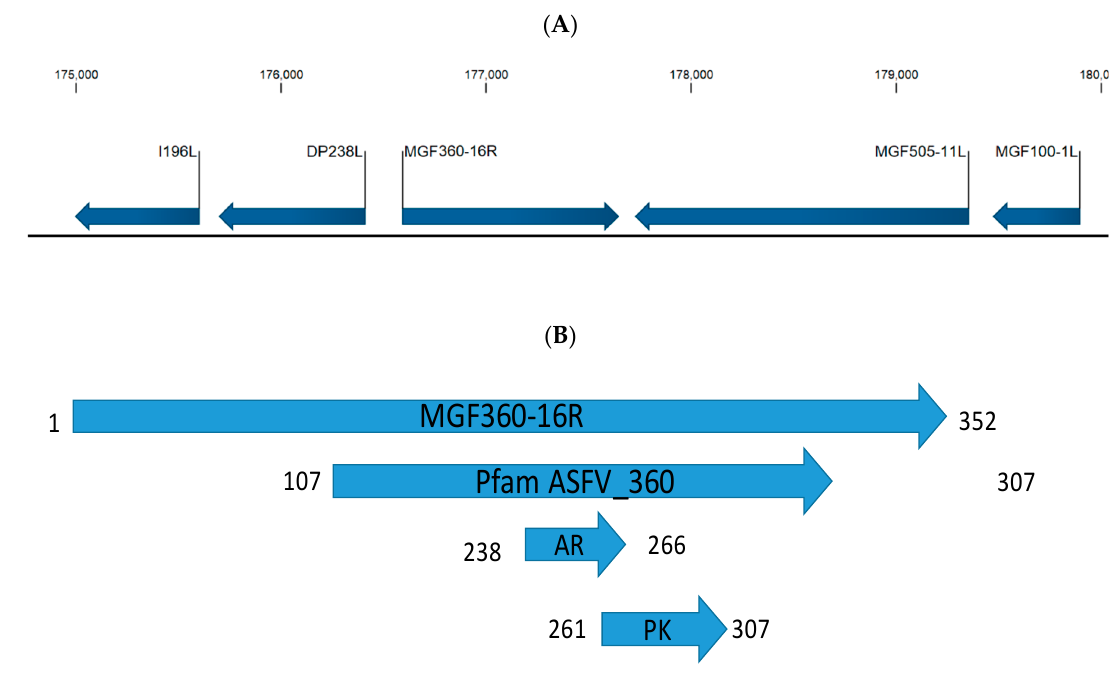
Figure 1. MGF360-16R open reading frame (ORF) description. ( A ) Schematic representation of the MGF360-16R ORF region in the African swine fever virus (ASFV)-G genome, showing adjacent open reading frames. ( B ) Schematic representation of the predicted domains in the MGF360-16R protein. Amino acid positions of the domains are on the ends of the protein domain. The domains include the pfam MGF360 domain, the ankyrin repeat domain (AR), and the protein-kinase-like domain (PK).